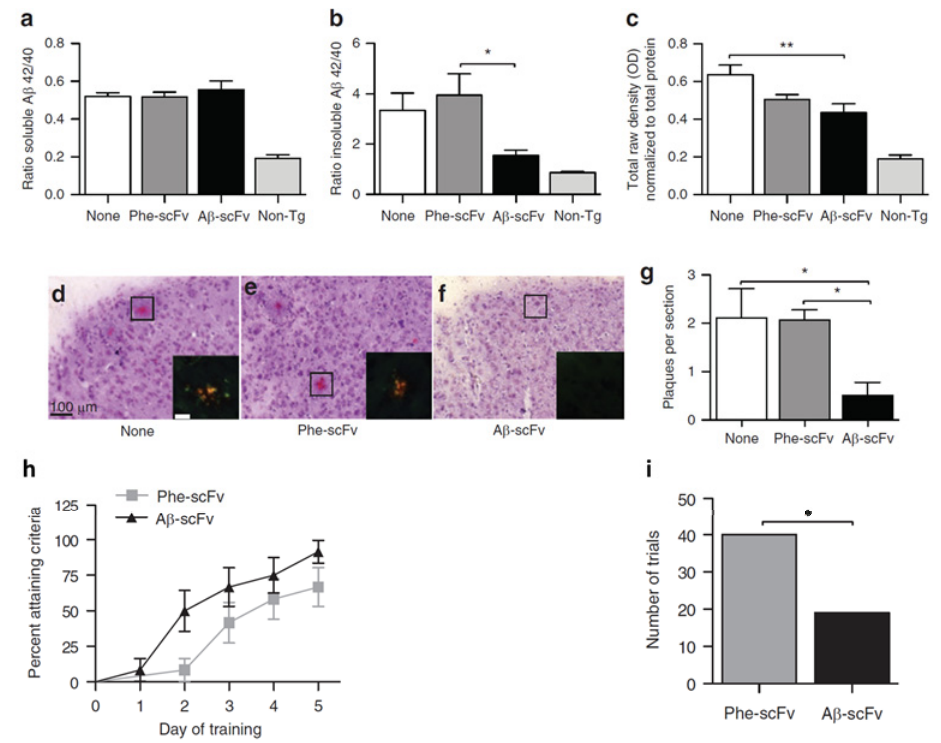
Figure 4. Assessment of recombinant adeno-associated virus (rAAV) delivered single-chain fragment variable (scFv) therapy for Alzheimer’s disease (AD) in 3xTg AD mouse model. Hippocampal injections of rAAV1-Phe-scFv (Phe-scFv), rAAV-A β -scFv (A β -scFv), or no injection control (None) into three-month-old 3xTg-AD mice led to no change in hippocampal soluble A β . ( a ) Levels but significant decreases in insoluble A β ; ( b ) Levels in the A β -scFv group; ( c ) The levels of soluble oligomeric A β in the A β -scFv treated mice was significantly decreased compared to mice with no